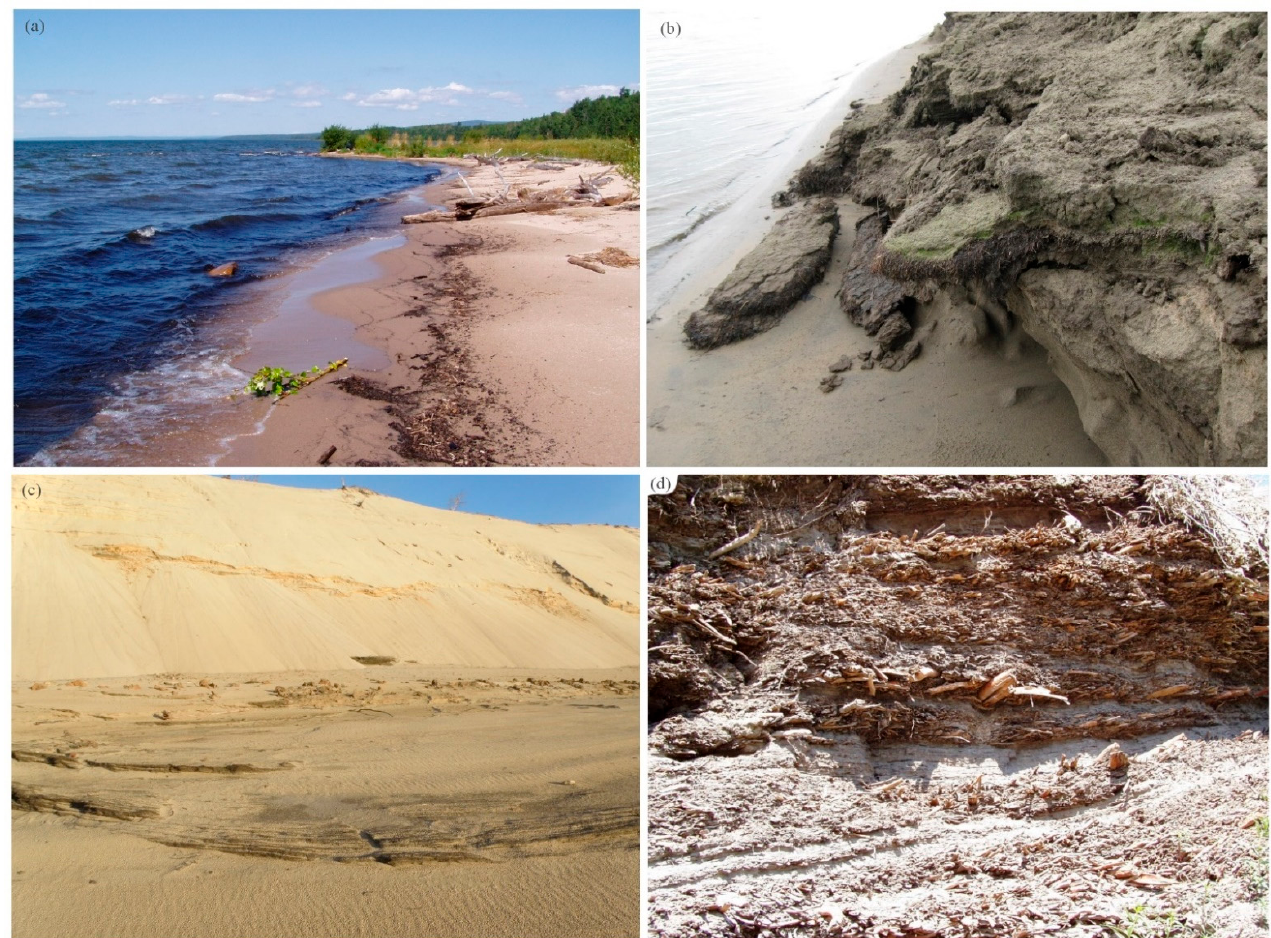
Figure 5. Grass and wood detritus: ( a ) plant detritus at the lake shore, Lesser Slave Lake, Canada, ( b ) modern alluvium with plant detritus at the Lena River, ( c ) section Kyzyl-Syr at the Viluy River, Yakutia with plant detritus layer at the base, ( d ) plant detritus in the section Old Crow River, CRH 44.